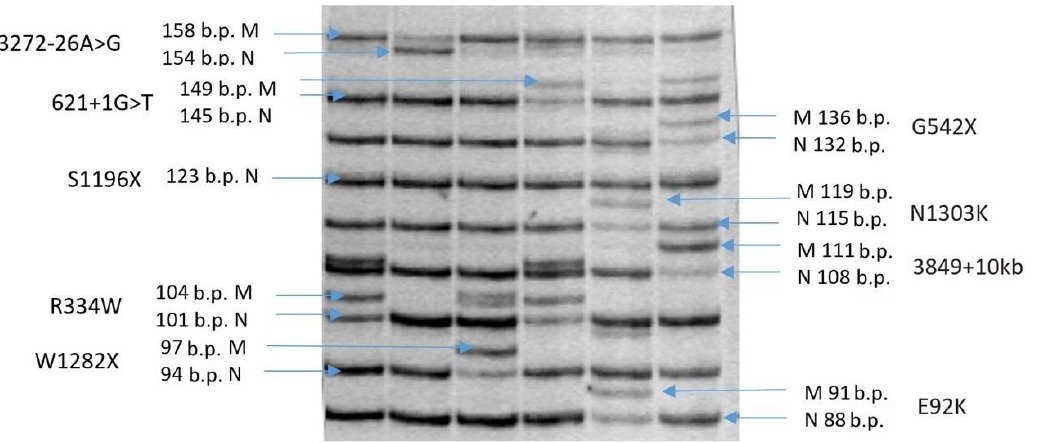
Figure 7. Fragment of an electrophoregram visualizing the detection system of the 9 most common pathogenic variants of the CFTR gene by allele-specific ligase reaction.